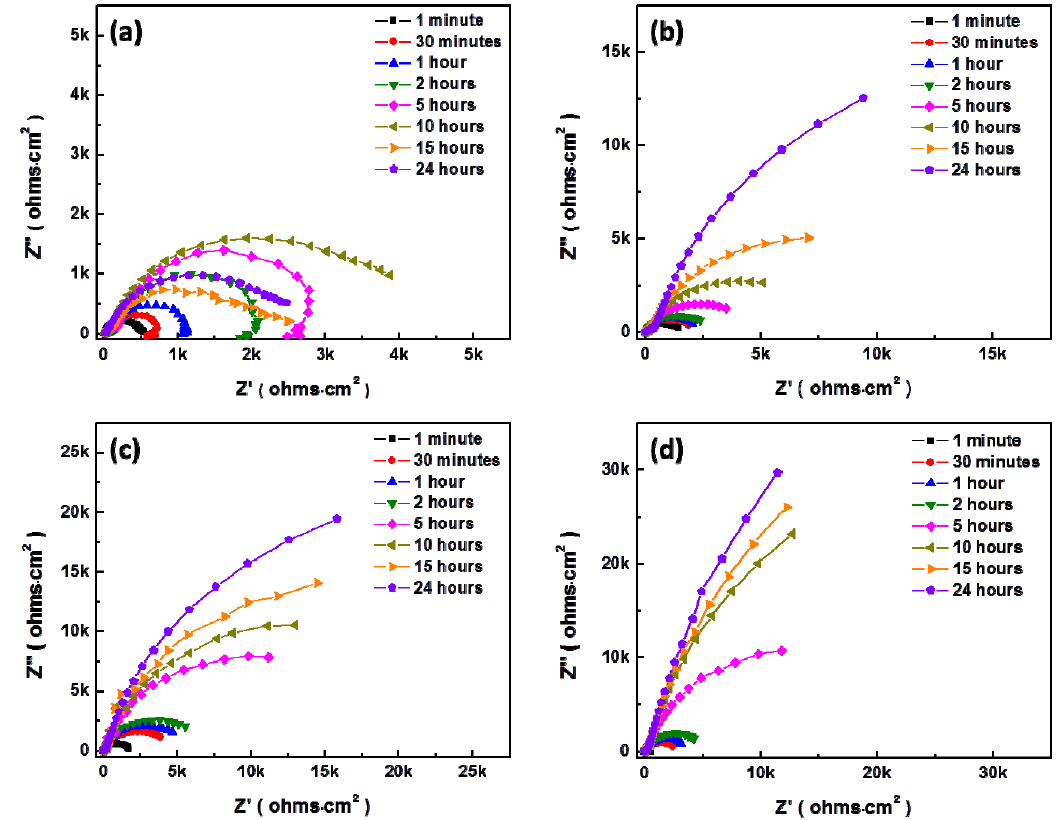
during immersion up to 24 3